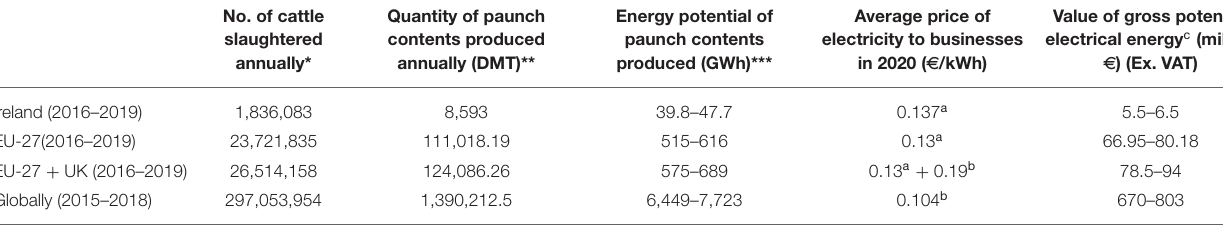
TABLE 2 | Economic value of potential energy stored in paunch contents on a DM